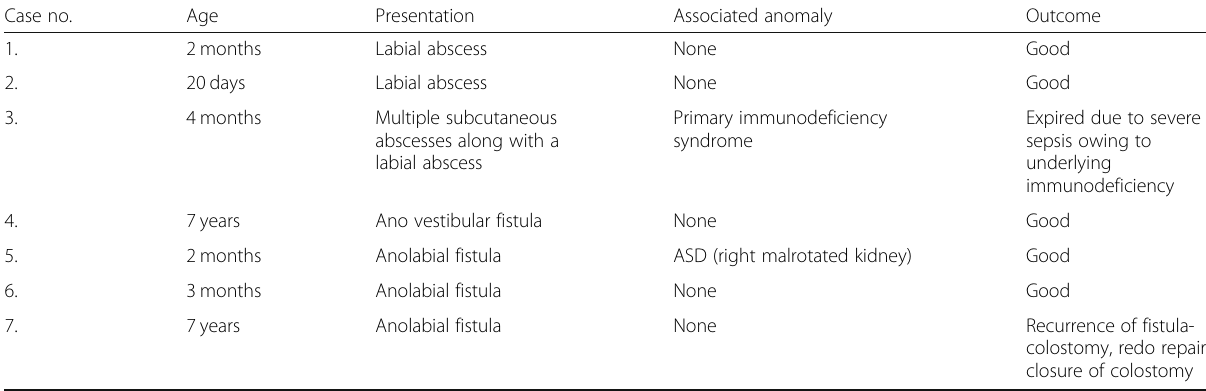
Table 1 Reviewed cases of female anorectal malformations Case no.